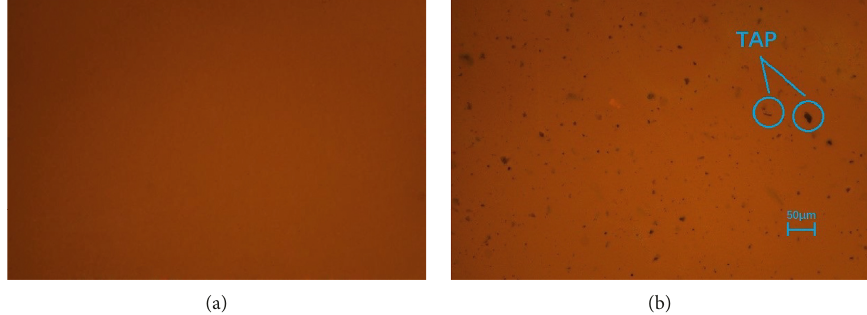
Figure 2: Morphologies of the (a) base asphalt and (b) TAP-modified asphalt. Table 7: Requirements of the aggregate gradation range and synthetic gradation of the AC-16 mixture. Mass percentage of aggregate passing through the following sieve holes (%) Gradation type